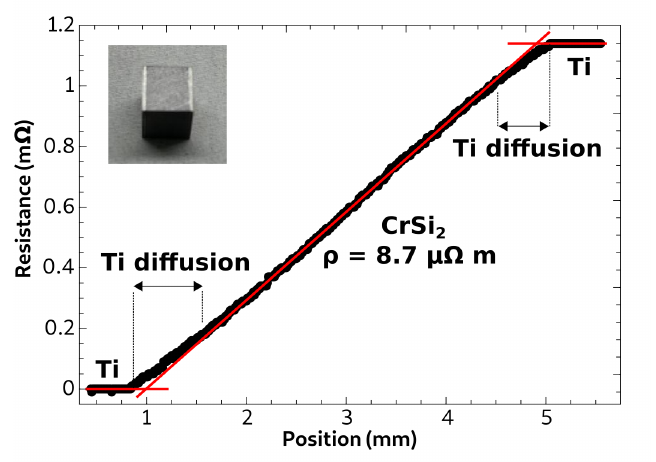
Figure 5. Scanning electrical resistance of the SPS Ti/CrSi 2 /Ti legs. The picture in inset shows the leg used for the measurement.